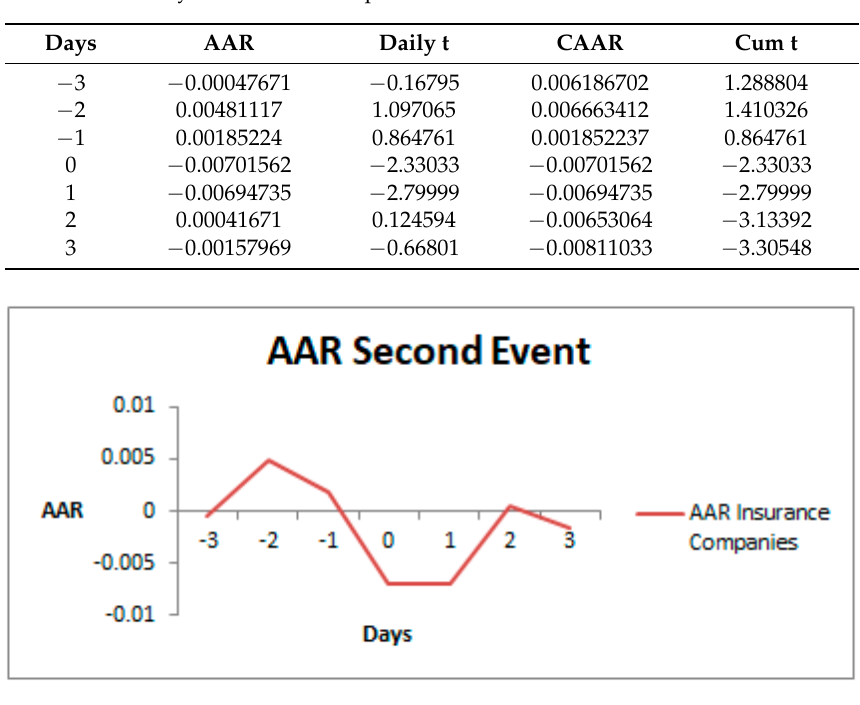
Figure 11. AAR for insurance companies. Source: Authors’ work. Lastly, Table 8 presents the empirical finding for the third event over an event window starting from day − 3 to day +3. The AAR for the event day was negative, − 0.00702, and not statistically signi fi cant. Conversely, the day +1, presented a negative AAR − 0.00601 which was statistically significant at 10%. This indicated that the market reacted negatively after the event was realised as showed in Figure 12.